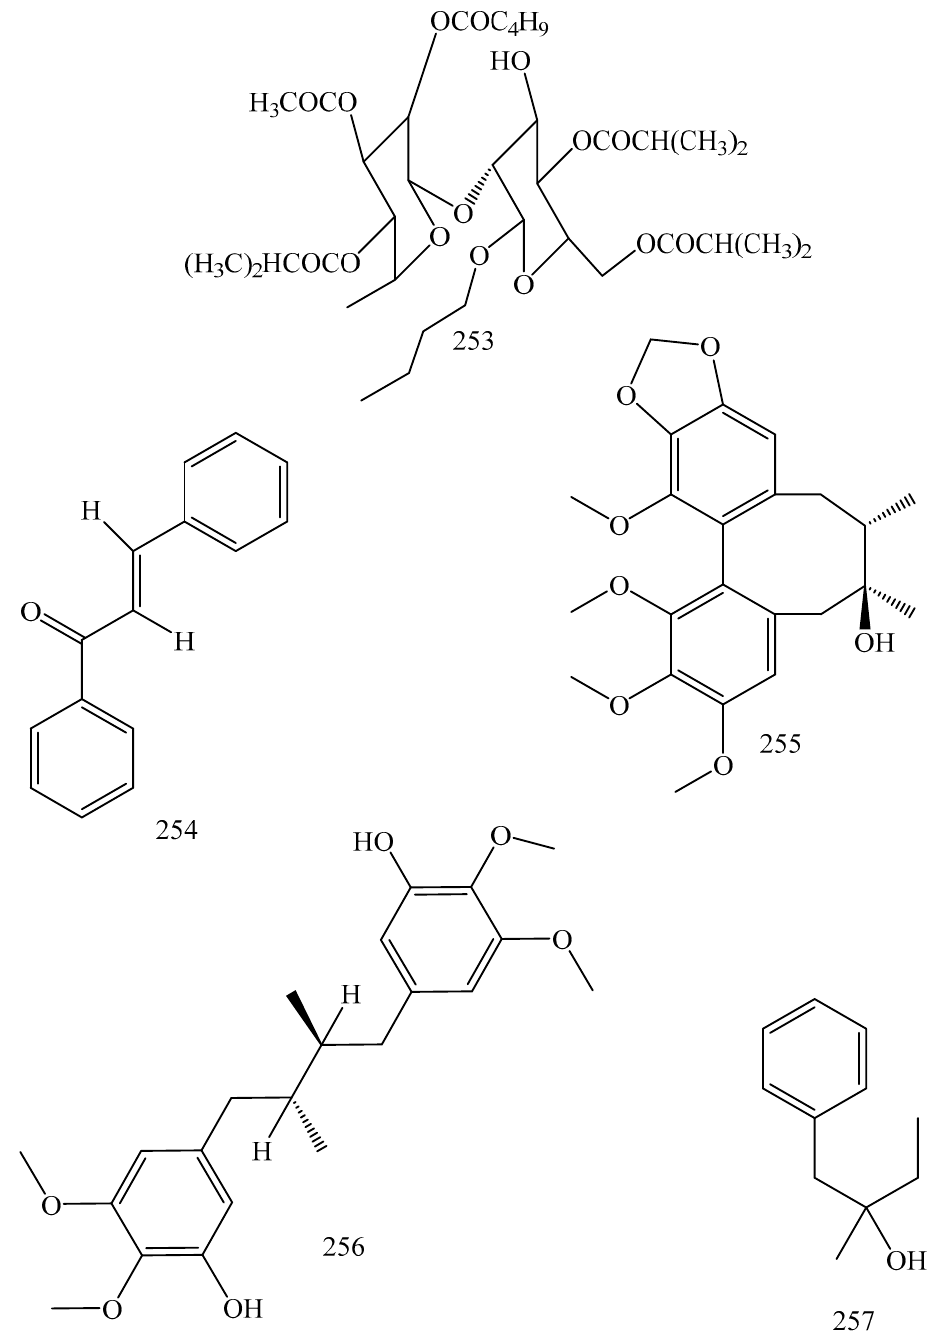
Figure 7. The structures of natural P-gp inhibitors mentioned in Table 3.